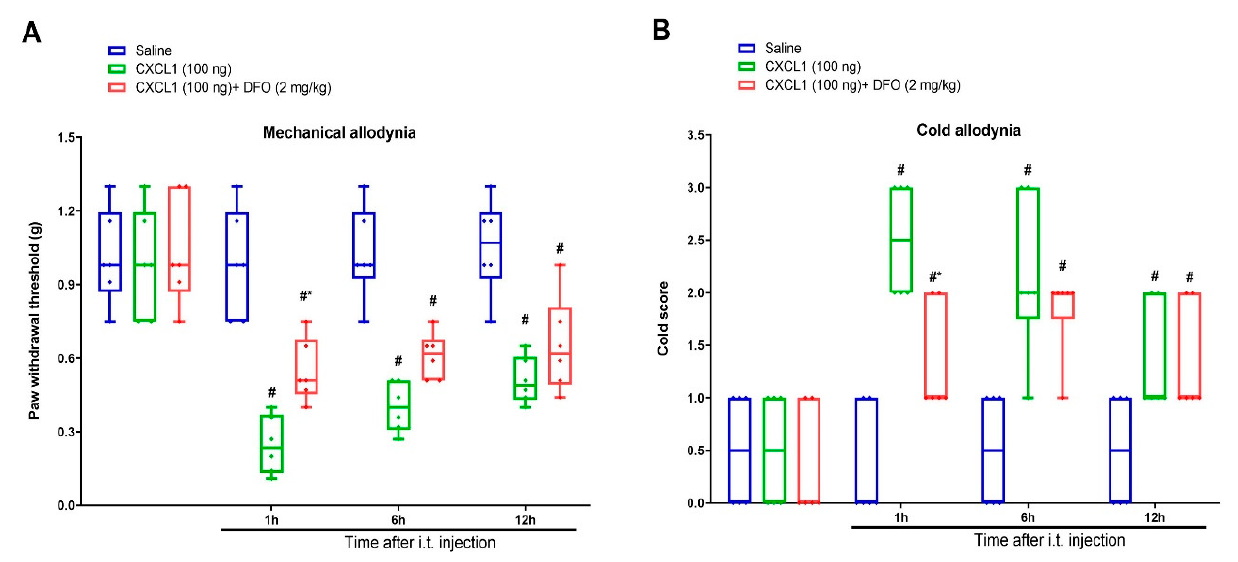
Figure 6. Spinal iron chelation prevents exogenous CXCL1-evoked acute allodynia behaviors. Re- combinant CXCL1 (100 ng) was intrathecally injected in naïve animals. Intrathecal iron chelator DFO (2 mg/kg) was injected 1 h prior to CXCL1 exposure. The paw withdrawal threshold ( A ) and cold responses to acetone ( B ) were documented following DFO and CXCL1 co-administration. The behavioral data ( n = 6) are analyzed by two-way ANOVA with Bonferroni post hoc comparisons. Results are expressed as medians with interquartile ranges and individual data plots. # p < 0.05 vs. group Saline, * p < 0.05 vs. group CXCL1 (100 ng).